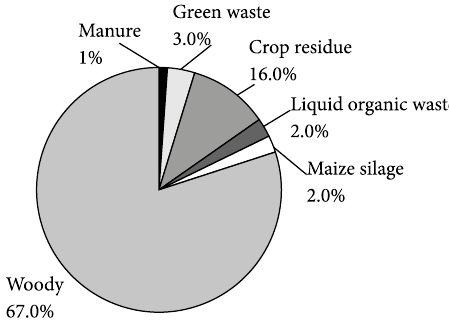
Fig. 2. Survey response of biochar feedstock types (n =